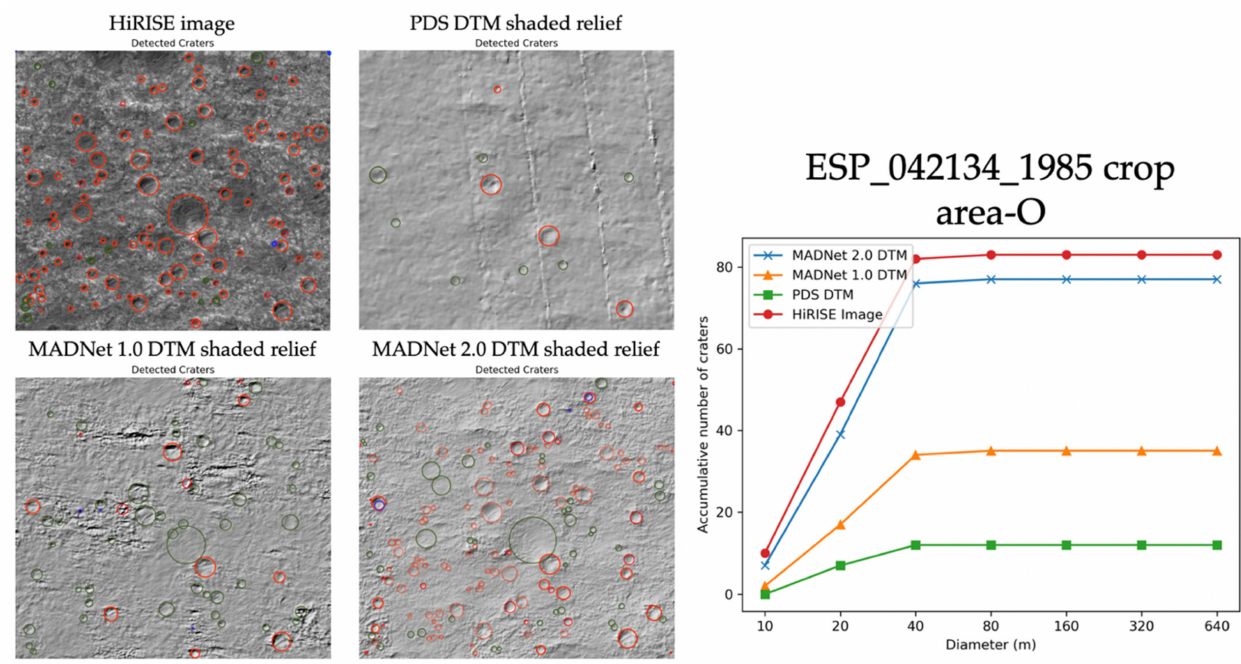
Figure 20. Crater detection and size-number counting from HiRISE image and the hill-shaded relief images of the PDS DTM, MADNet 1.0 DTM, and MADNet 2.0 DTM, over a 500 m × 500 m cropped area (area-K of ESP_042134_1985_RED). N.B. automatically detected craters are in red circles; manually excluded false-positives are in blue circles; manually added true-positives are in green